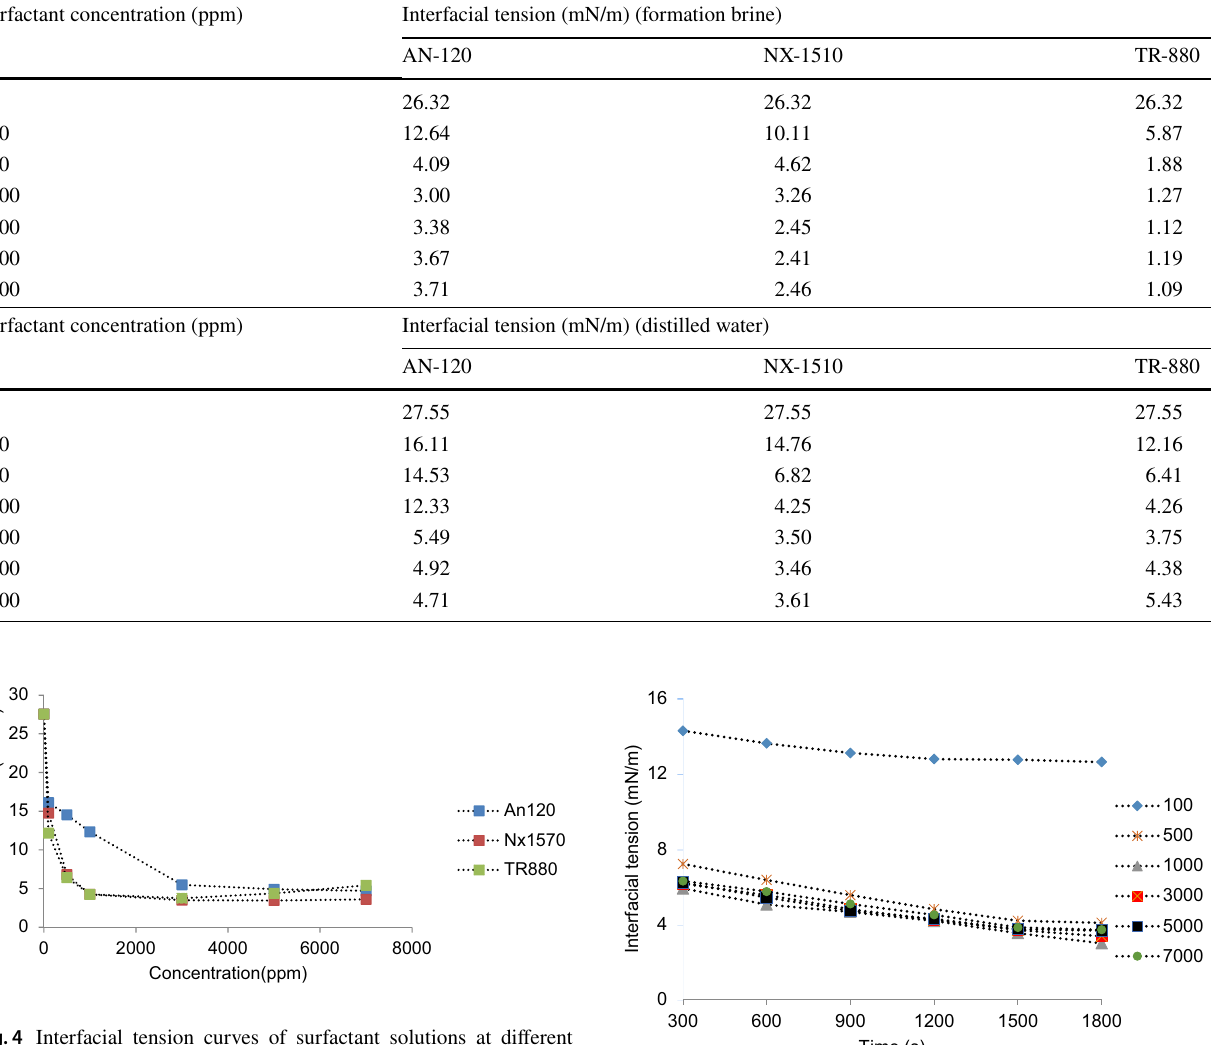
Fig. 4 Interfacial tension curves of surfactant solutions at different concentrations with distilled water base and crude oil at 351.15 K and pressure of 14.7 psi